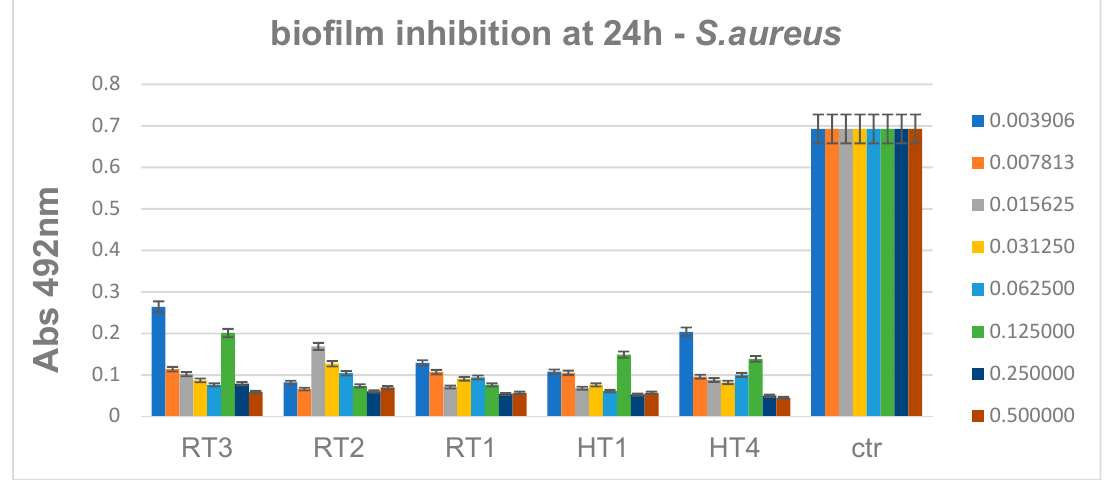
Figure 18. Inhibition of S. aureus biofilm development in the presence of the obtained AgNPs for 24 h, p < 0.001 when comparing Abs 492 nm values of RT and HT samples to control.